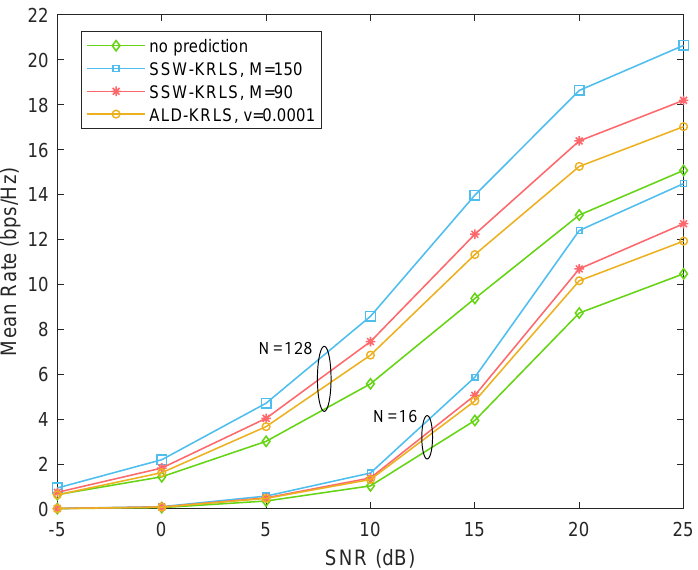
Figure 7. Performance comparison among no prediction (last uplink measurement), the ALD-KRLS algorithm, and the proposed SSW-KRLS algorithm. β = 0.97, v = 60